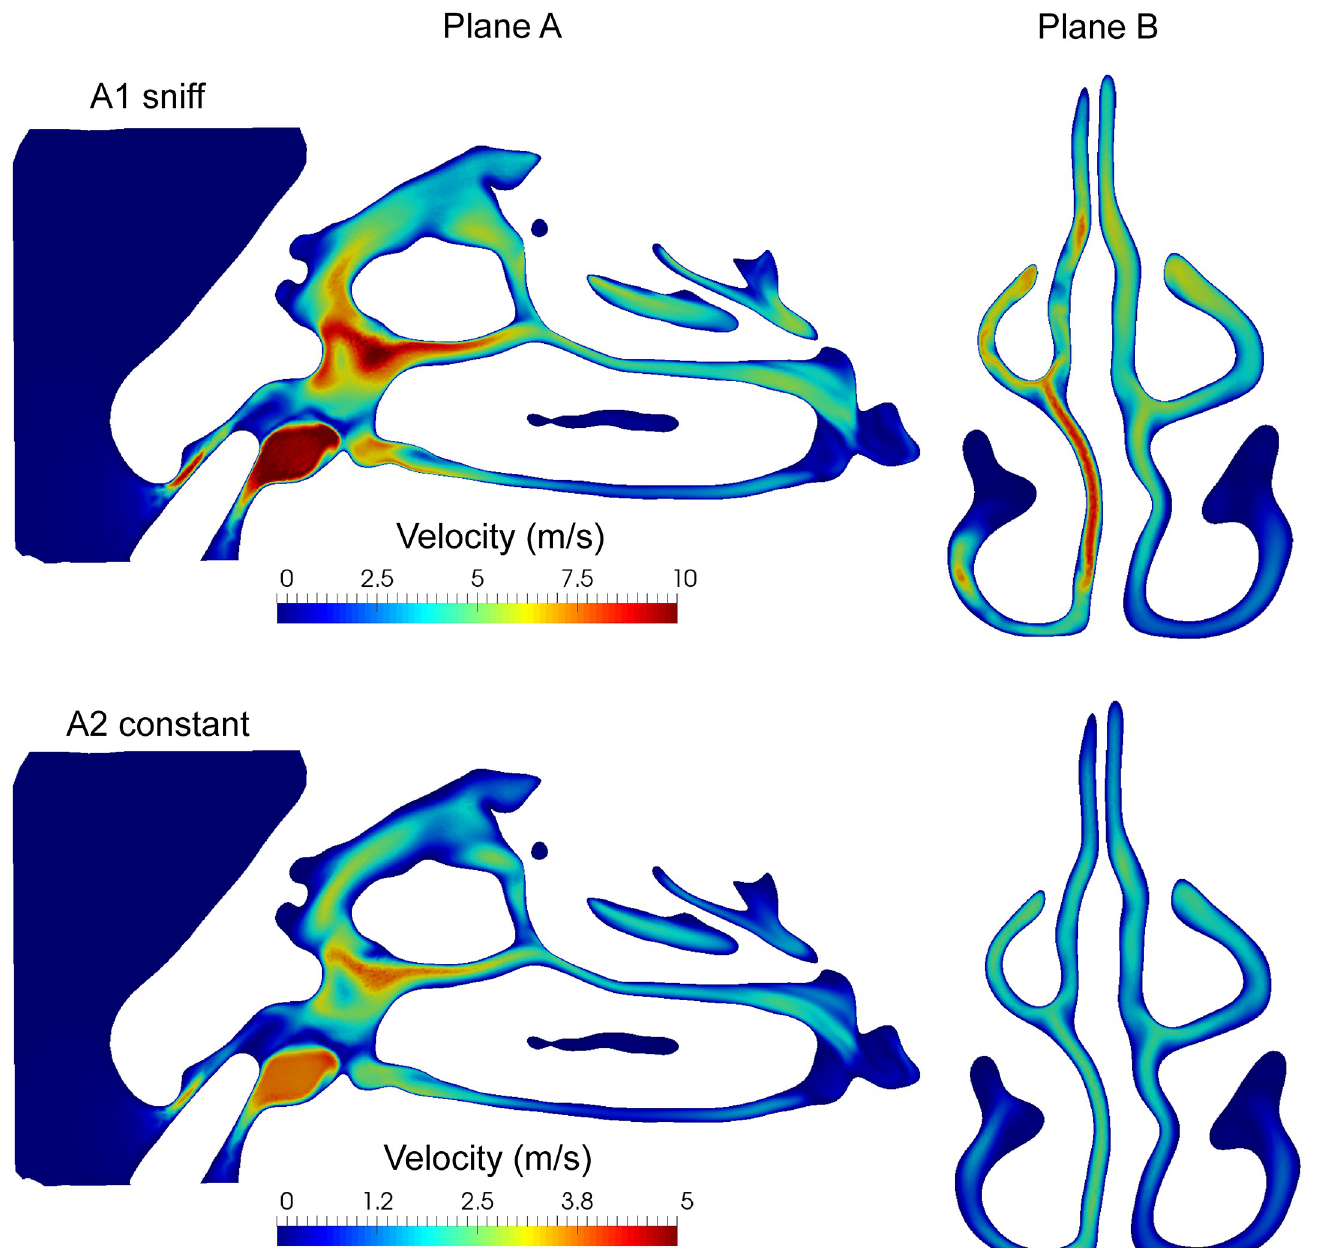
Fig 11. Mean velocity of sagittal plane of left nasal cavity (plane A) and coronal plane in the middle of nasal cavity (plane B) computed for the time period 0.1s to 0.15s for A1 and A2 inhalation conditions.